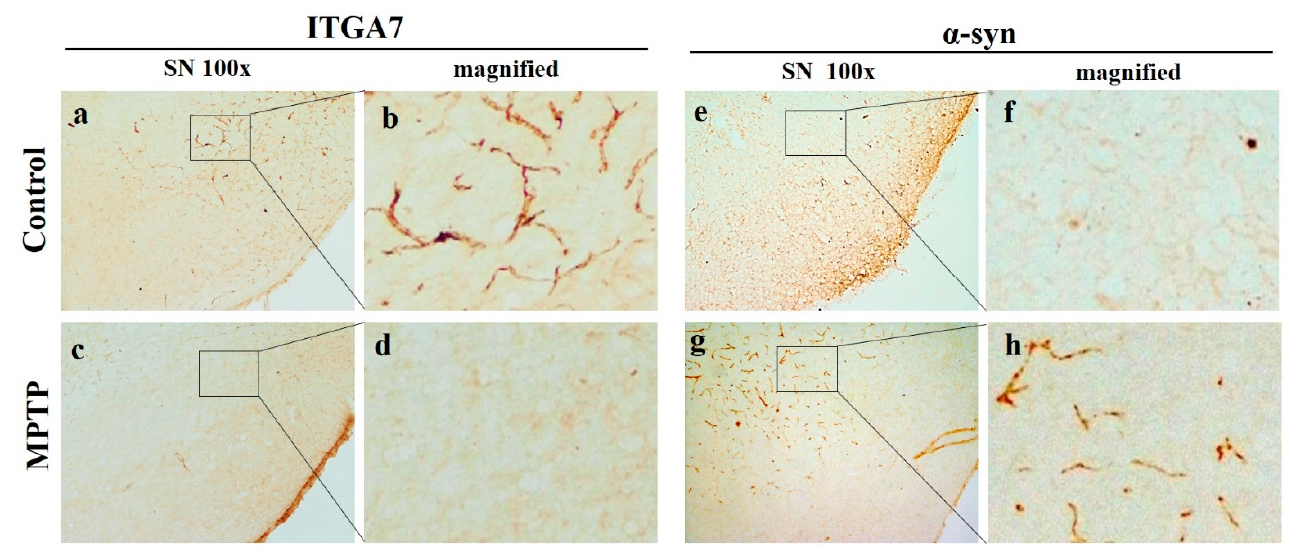
Figure 3. Representative images of (ITGA7) and α -synuclein ( α -syn) expression in the SN in a chronic 1-methyl-4-phenyl- 1,2,3,6-tetrahydropyridine (MPTP)-induced Parkinson’s disease mouse model. The expression of ITGA7 ( a – d ) was de- creased ( c , d ) and the expression of α -syn ( e – h ) was increased ( g , h ) in in the MPTP group. Images of ( b , d , f , h ) are magnified images of squares in ( a , c , e , g ).